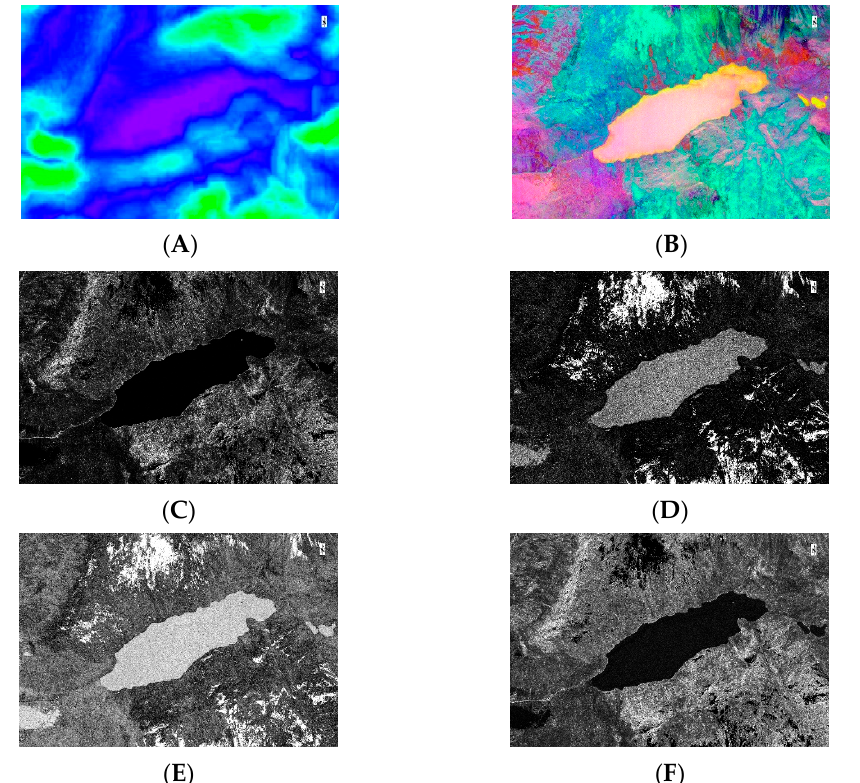
Figure 10. ( A ) Relief feature; ( B ) PCA feature; ( C ) Contrast feature; ( D ) Angular second-order mo- ment feature; ( E ) Homogeneity feature; ( F ) Phase dissimilarity